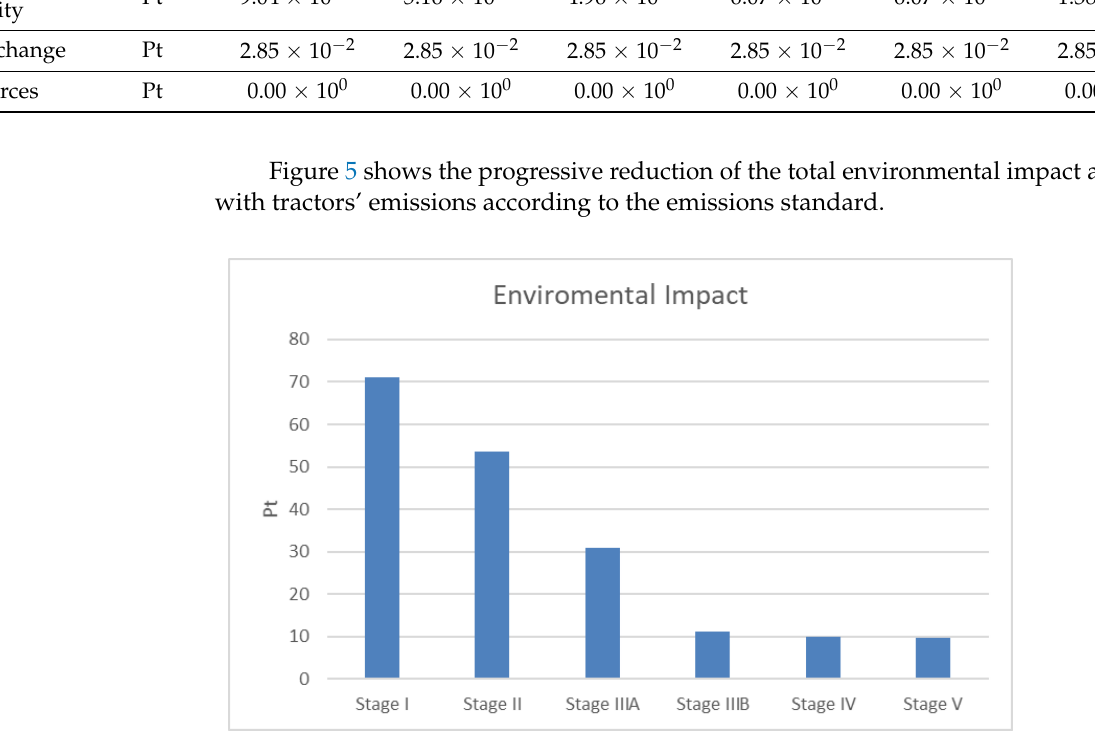
Figure 5. Evolution of the environmental impact of tractor emissions.